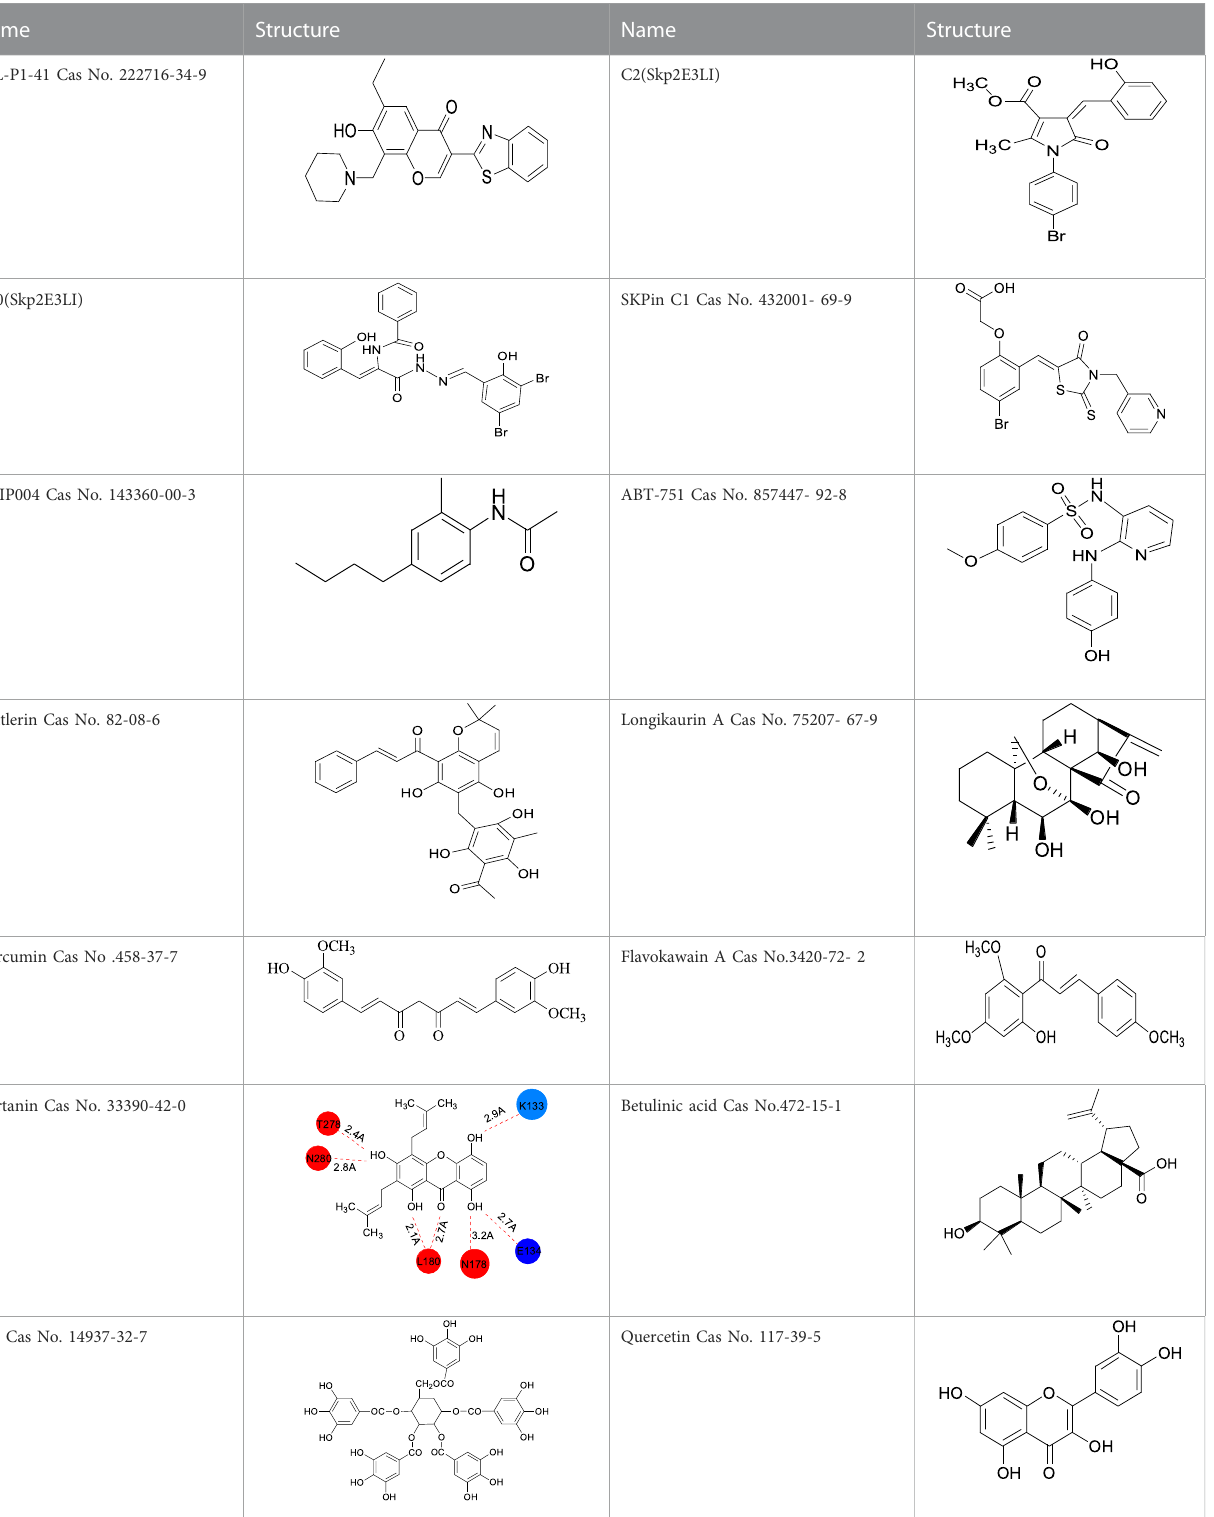
TABLE 1 Structures of some of the Skp2 inhibitors or inhibiting compounds in this review.